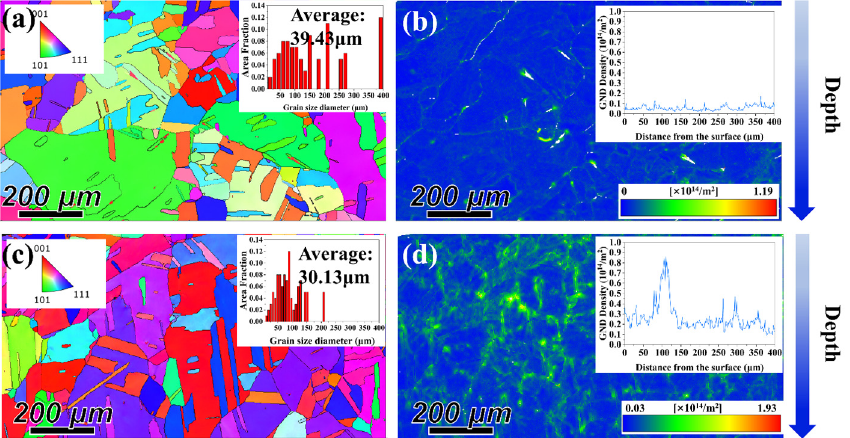
Figure 8. Microstructural characteristics in HAZ on side 1Gr18Ni9Ti of combustion liner weld with LSP and UN-LSP: ( a ) IPF mapping with UN-LSP; ( b ) GND density mapping with UN-LSP; ( c ) IPF mapping with LSP; ( d ) GND density mapping with LSP.